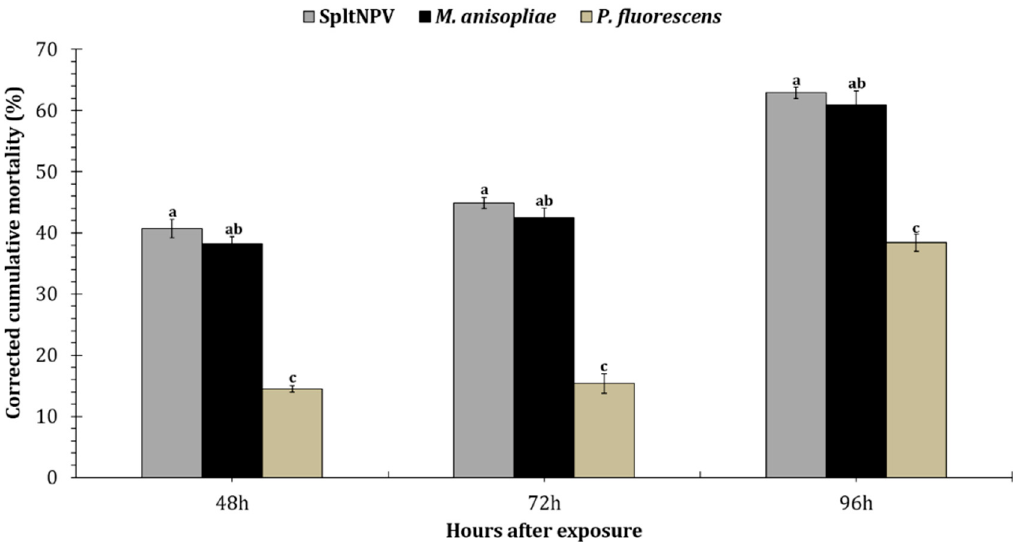
Figure 2. Effect of Spodoptera litura nucleopolyhedrovirus (SpltNPV), Metarhizium anisopliae , and Pseudomonas fluorescens microbe-treated cotton leaf disks on the larval mortality of Spodoptera litura 48, 72, and 96 h post-exposure. All values are represented as means ± SEM. Letters above the mean bars per treatment/exposure time that are different are significantly different (Tukey’s test; p < 0.05).